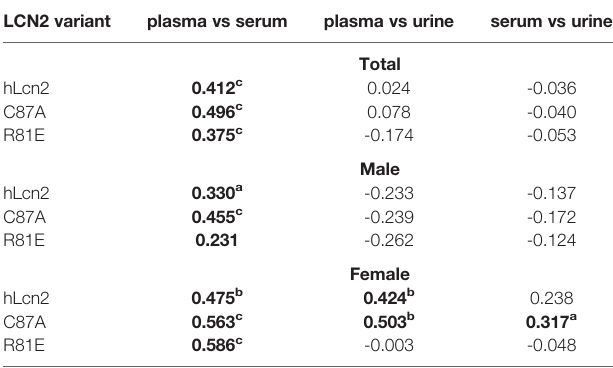
TABLE 3 | Correlations between LCN2 variants in different